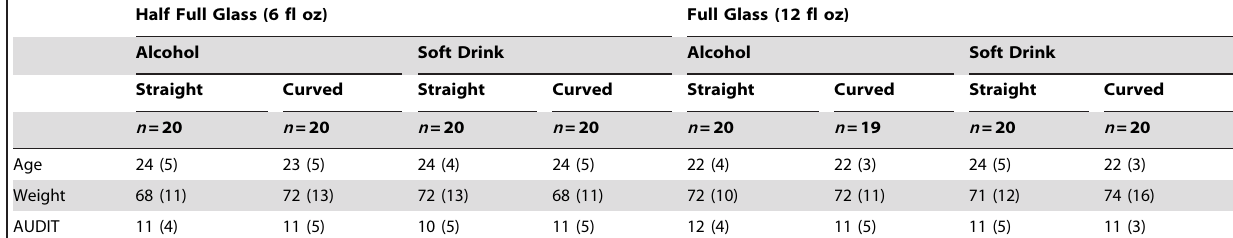
Table 1. Characteristics of Participants.